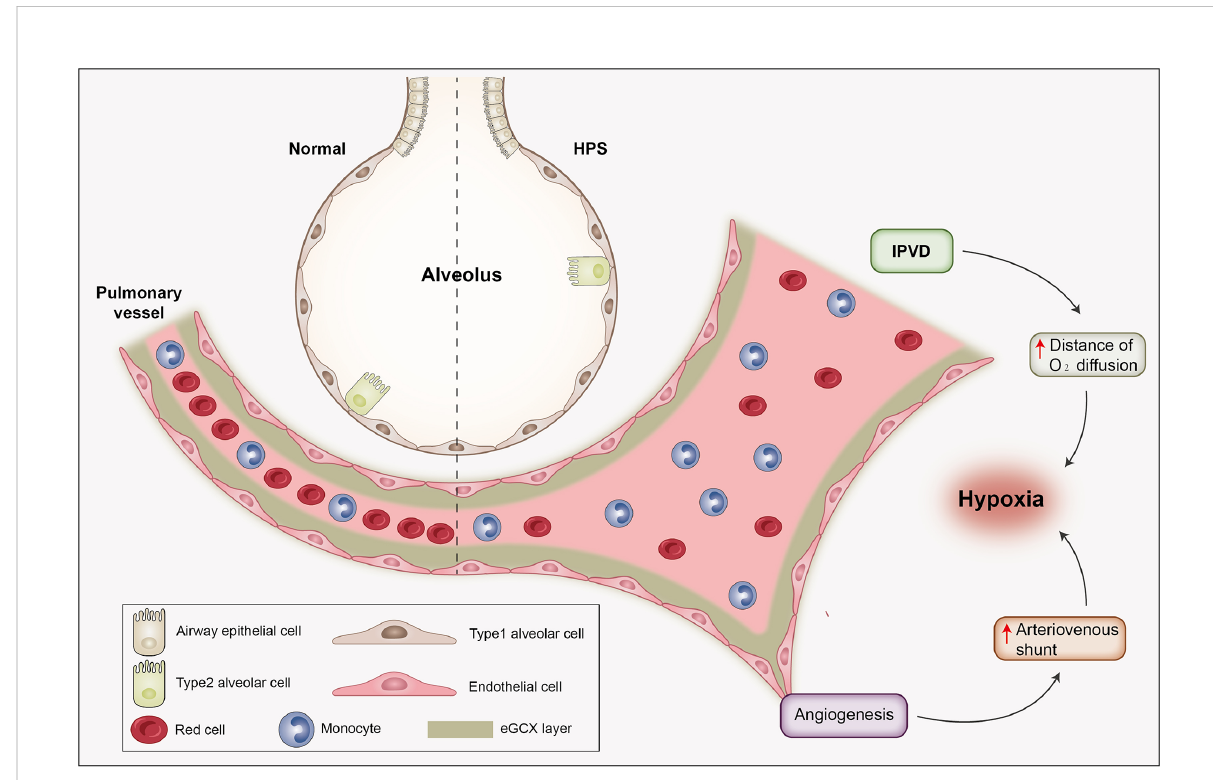
FIGURE 2 The pathophysiological alterations of HPS. HPS develops with two central pathogenic features — vasodilatation and angiogenesis. Intrapulmonary vascular dilation is the most important pathological process in HPS, resulting in elongated distance of oxygen diffusion and incomplete oxygenation of returned venous blood. Angiogenesis gives rise to intrapulmonary shunt and exacerbates ventilation/perfusion mismatch. These collectively lead to gas exchange abnormality and hypoxia. Abbreviation: IPVD, intrapulmonary vascular